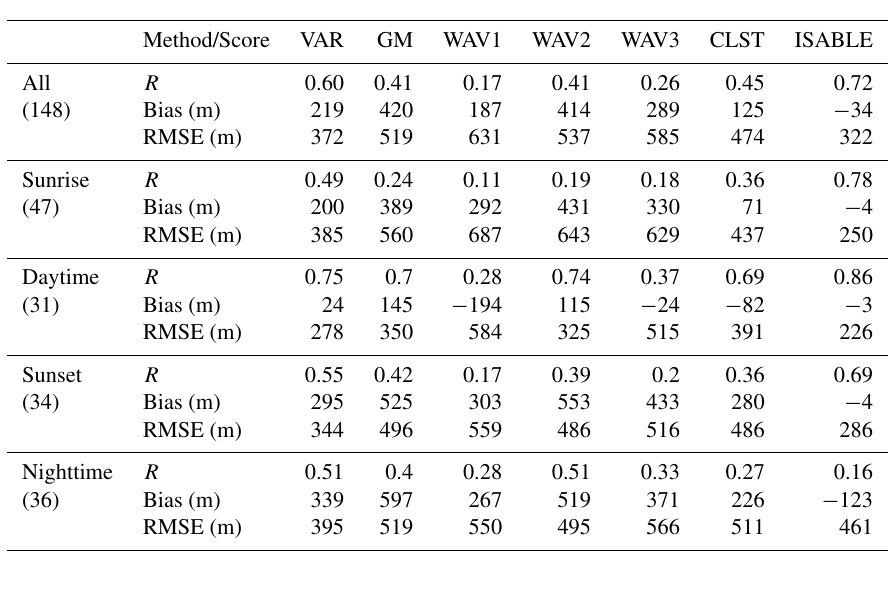
Table 2. Statistical performance between ABLHs obtained by various methods, including ISABLE and radiosonde observations for all data ( N = 148), sunrise ( N = 47; 06:00 to 11:00LST), daytime ( N = 31; 12:00 to 17:00LST), sunset ( N = 34; 18:00 to 22:00LST), and nighttime ( N = 36; 23:00 to 05:00LST).